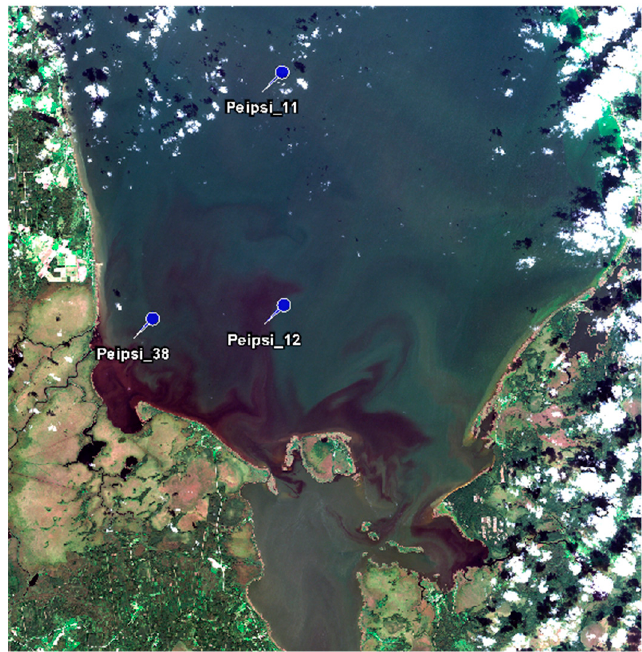
Figure A8. S2 MSI image of Peipsi from 14th of September 2016.